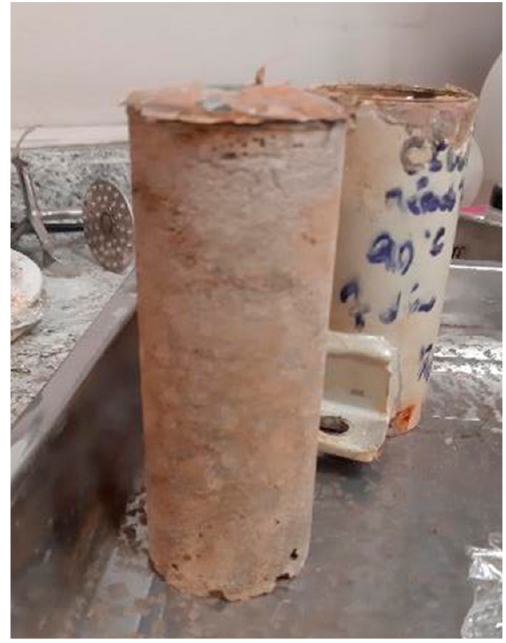
Figure 20. Consistency of Method VII, 7 days at 90 ◦